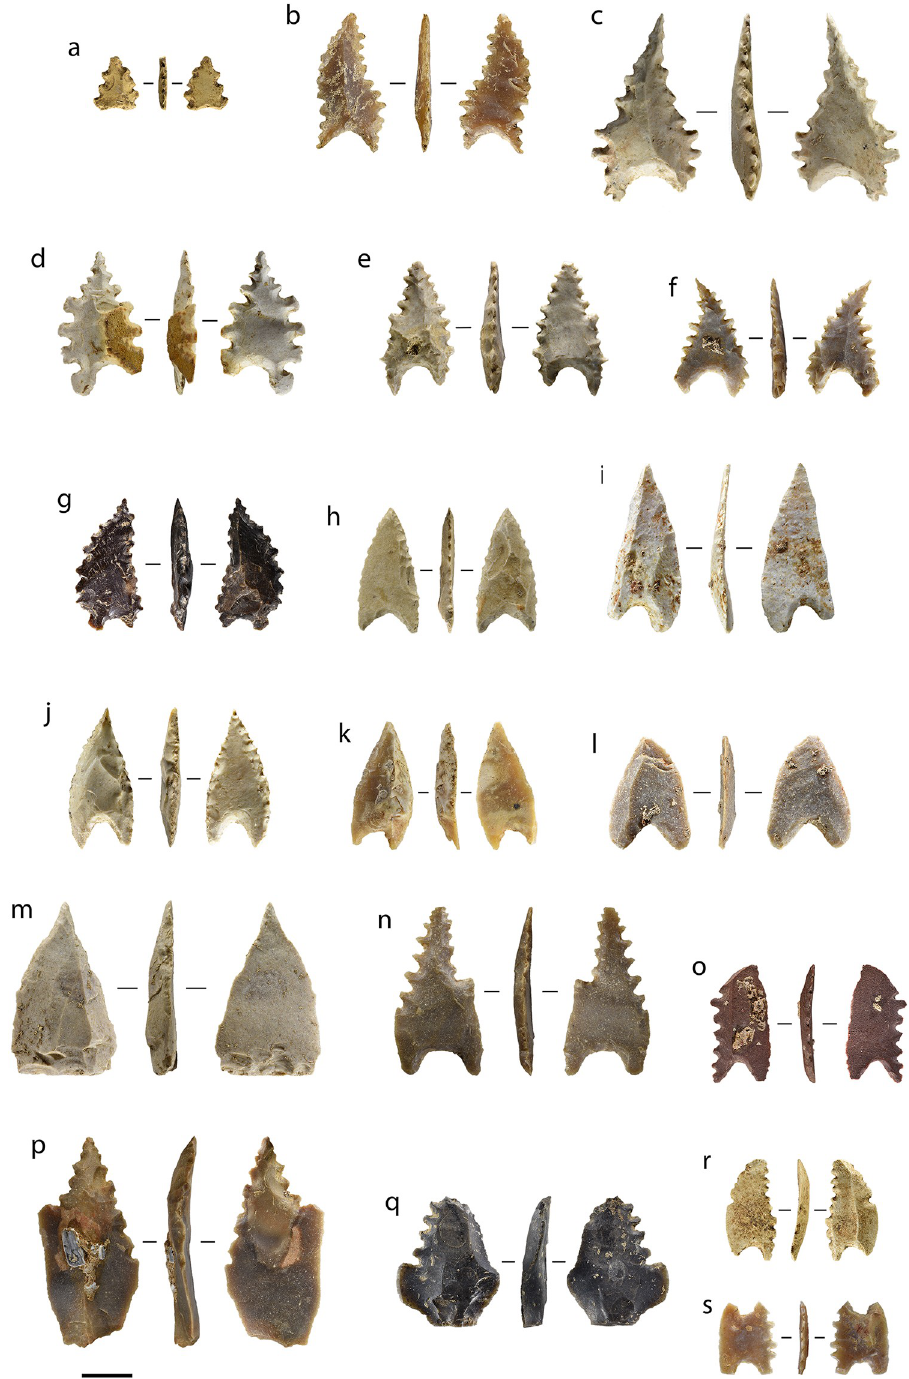
Fig 14. Toalean points. (a)–(g) Classic Maros points; (h)–(i) Lompoa points; (m) Pangkep point. (n), (o), (r) Appear to be unfinished classic Maros points; (p)–(q) Mallinrung points. Some artefacts may not be clearly classifiable, such as the double-based example (s). Scale bar = 1